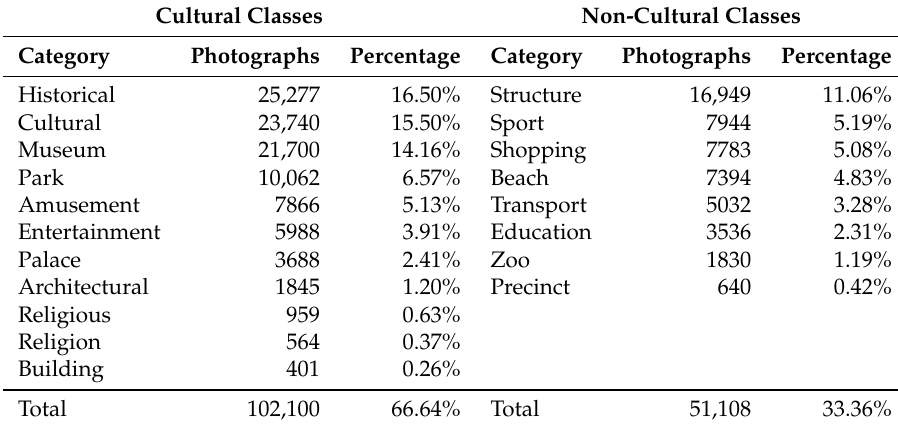
Table 6. POI Categories &